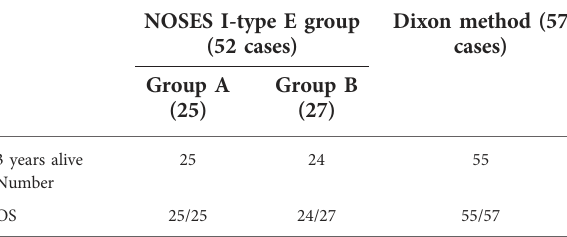
TABLE 8 The survival rate of the four groups at the 3-year